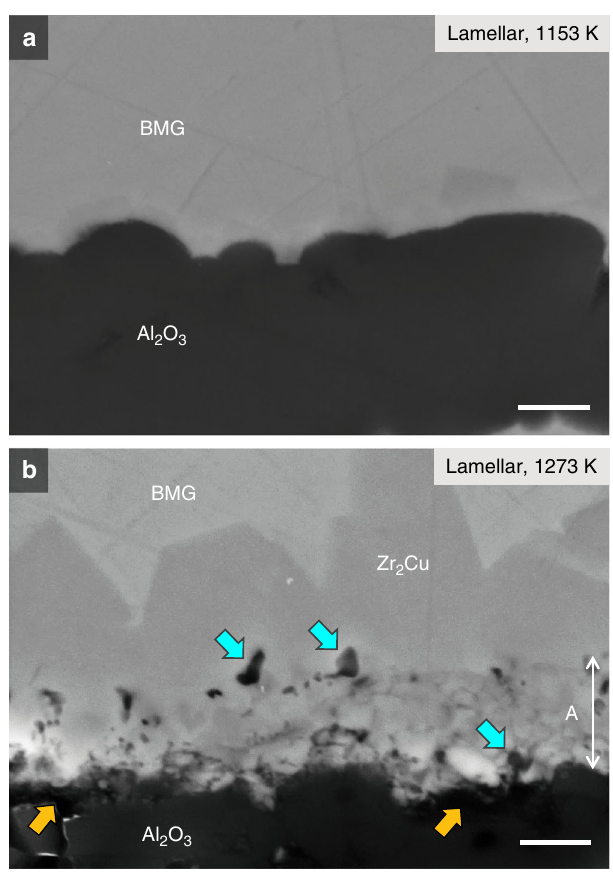
Fig. 10 SEM micrographs showing the interface of the compliant-phase alumina/BMG-forming materials with a lamellar structure in fi ltrated at 1153 and 1273 K. a The material in fi ltrated at 1153 K displays a sharp interface between the metallic mortar and alumina, and faceted crystalline (Zr 2 Cu) phase with a thickness of 0.3 ± 0.2 μ m. b In contrast, the interface of the material in fi ltrated at 1273 K reveals erosion of the interface, which produces a rough boundary, due to the signi fi cant reaction between